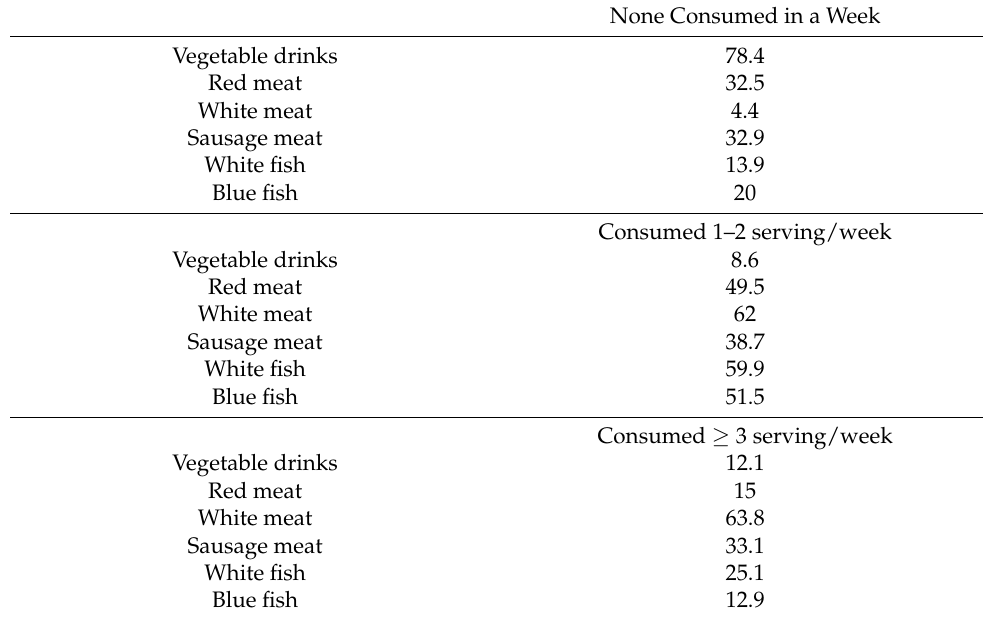
Table 3. Weekly food consumption (values are expressed as